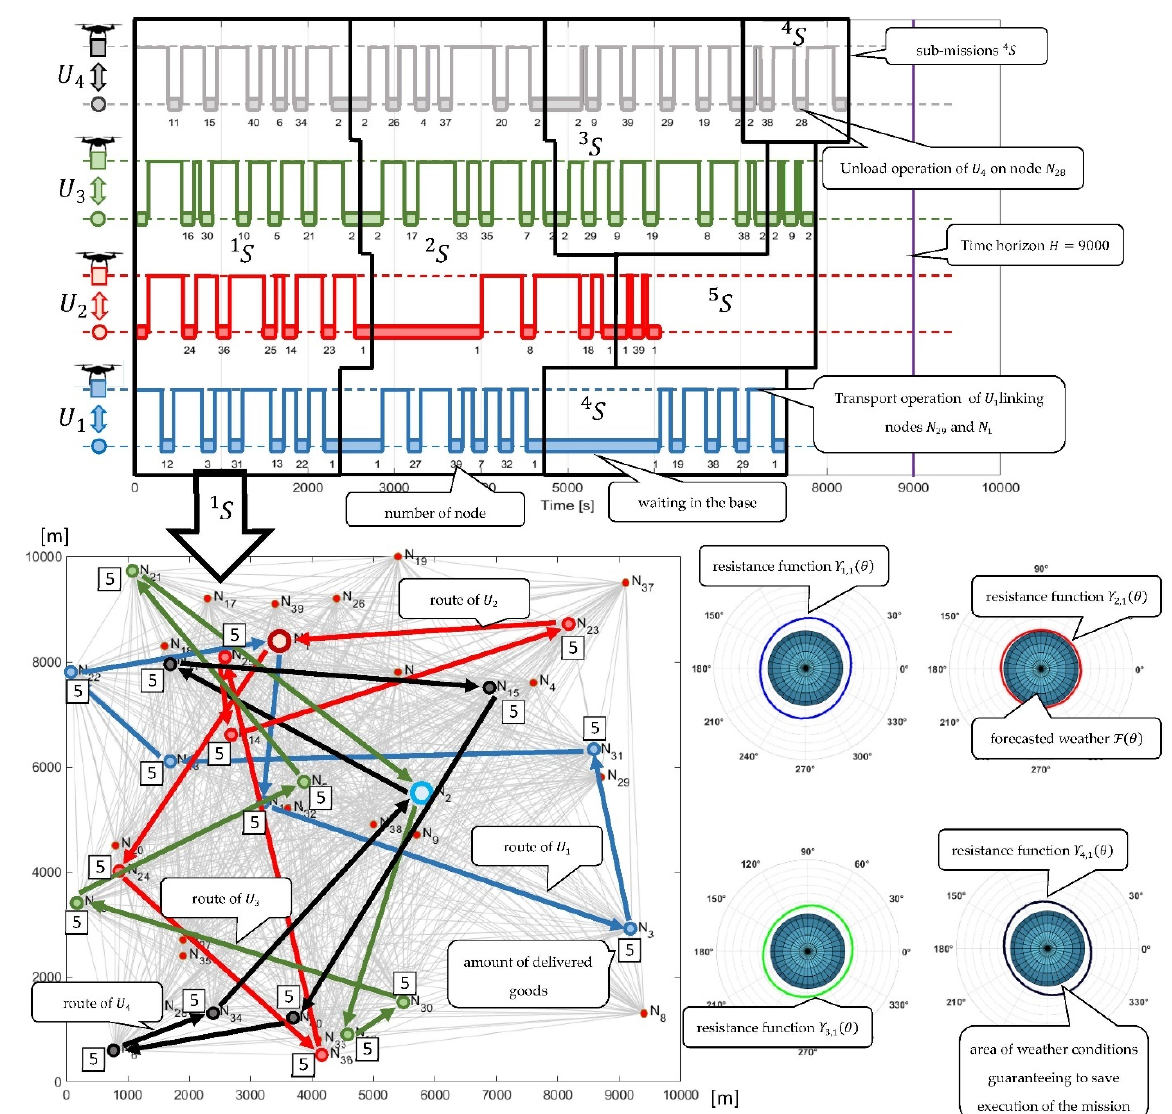
Figure 2. Examples of delivery missions for the fleet 𝒰 (cid:3404) (cid:4668)𝑈 (cid:2869) ,𝑈 (cid:2870) , 𝑈 (cid:2871) , 𝑈 (cid:2872) (cid:4669)